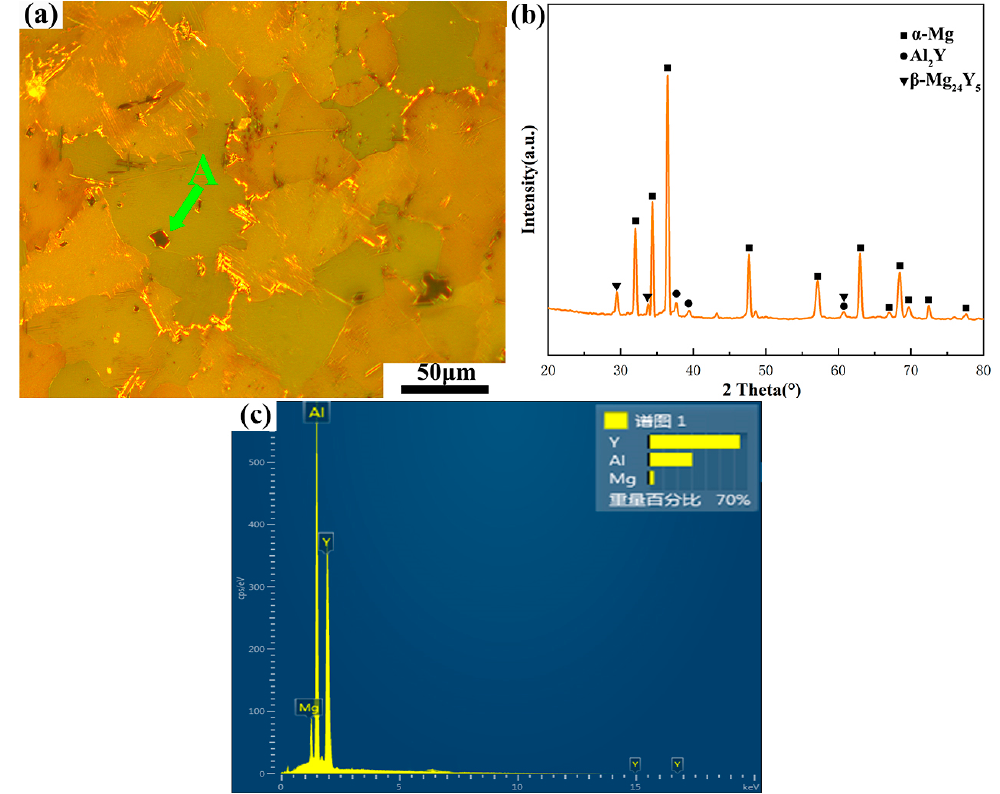
Figure 2. Microstructure of as-cast Mg-1Al-12Y alloy: ( a ) OM image, ( b ) XRD pattern and ( c ) EDS image of point A.